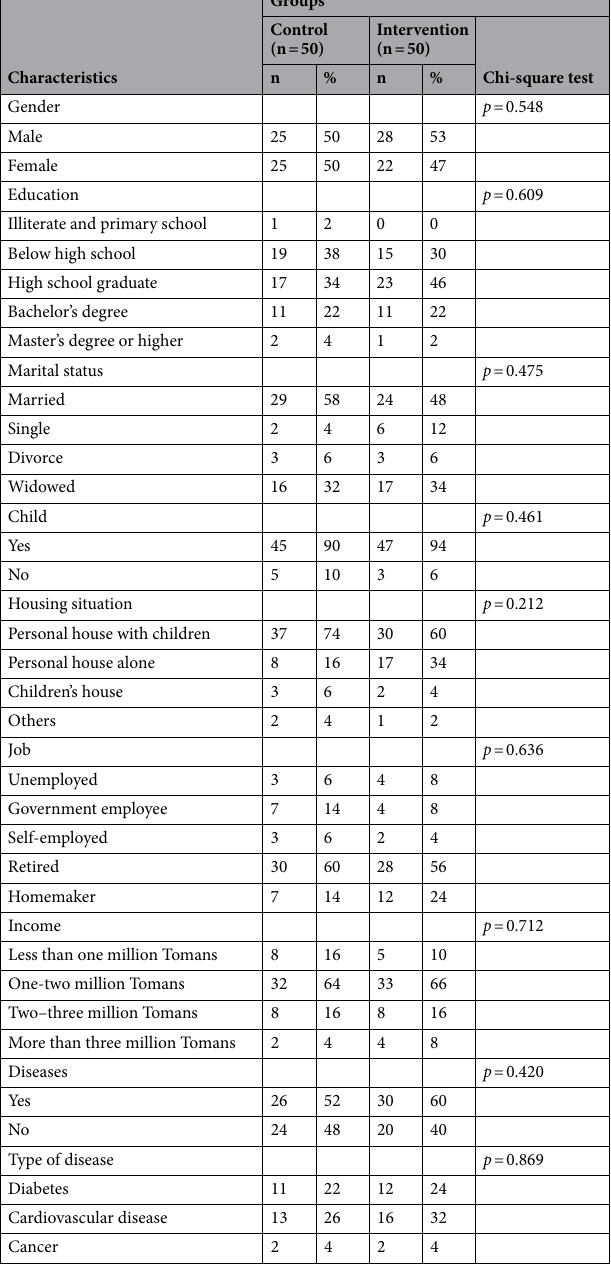
Table 1. Demographic characteristics of the participants in the study groups.